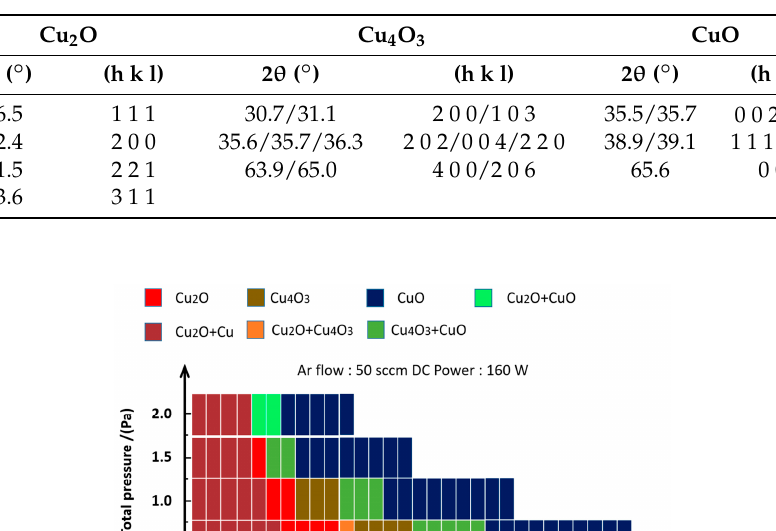
Table 1. The summary of diffraction peaks in XRD patterns.